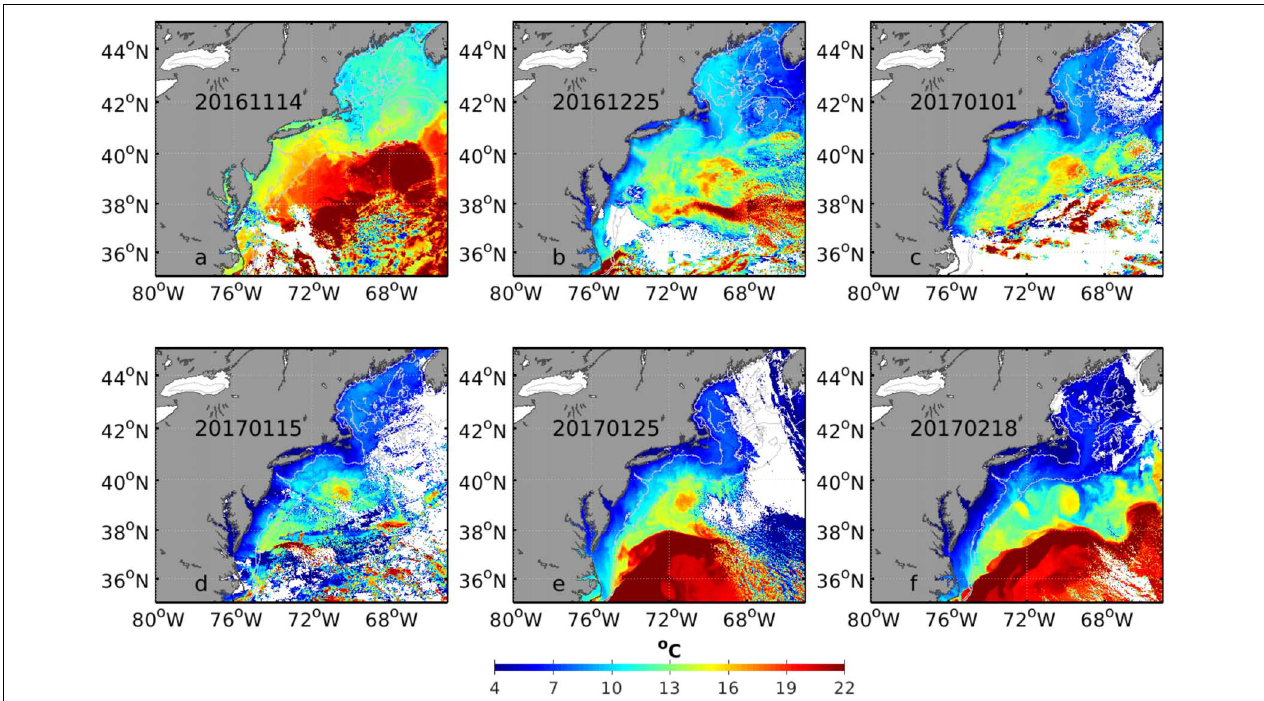
FIGURE 5 | A sequence of Sea Surface Temperature images of the Middle Atlantic Bight from November 14, 2016 through February 18, 2017. The dates are given in the upper left portion of each panel. The 50 and 200 m isobaths are also plotted.